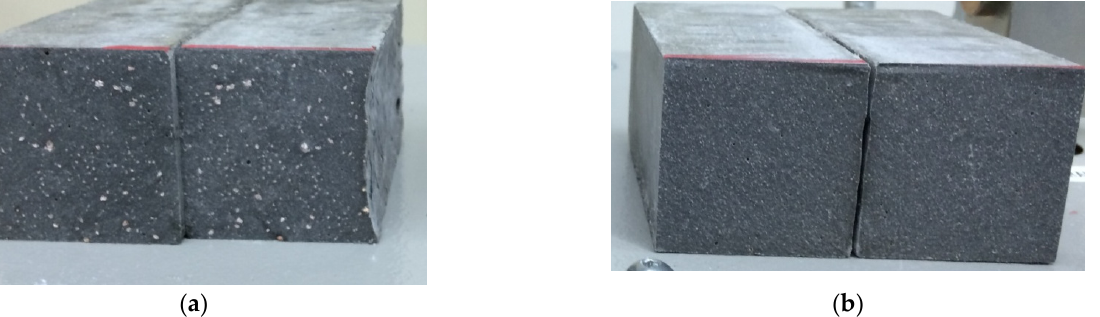
Figure 6. Samples after flexural breaking ( a ) microcapsules prepared using the original procedure and ( b ) microcapsules prepared using AOT.